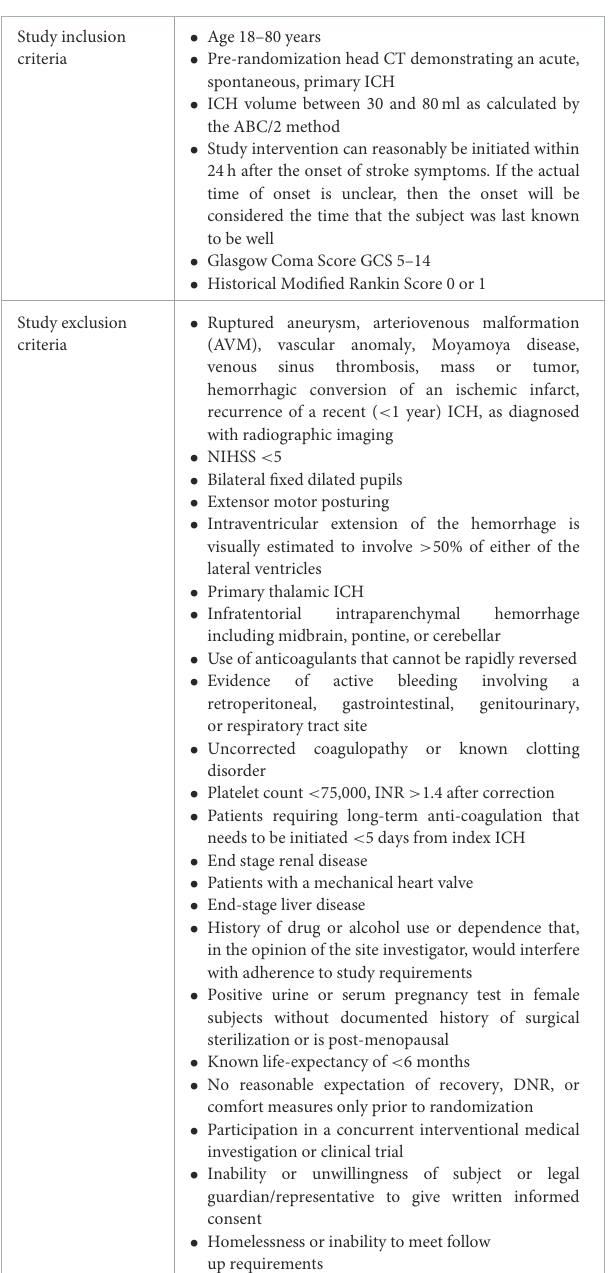
TABLE 2 Inclusion and exclusion criteria. TABLE 3 mRS values to utility weights